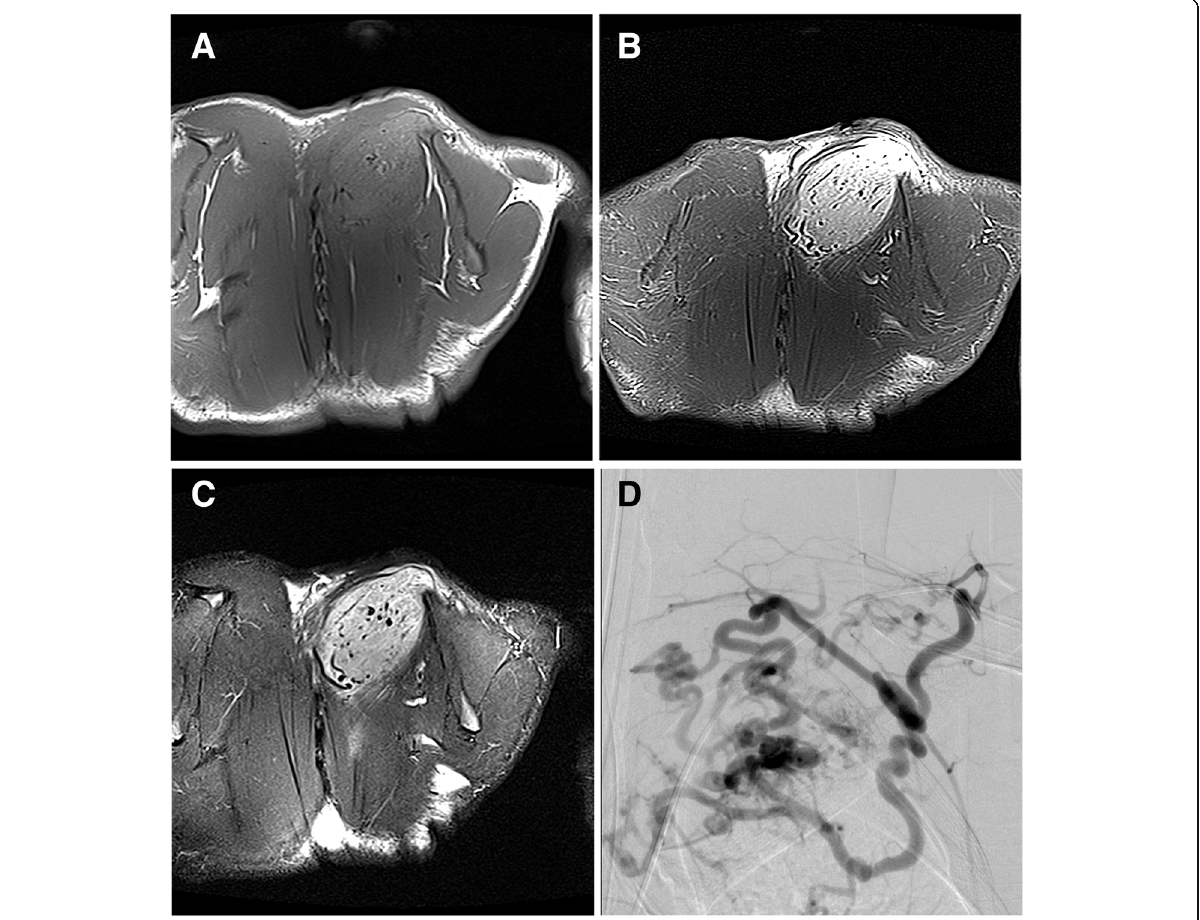
Fig. 1 a , b Pre- and post-contrast coronal T1-weighted images, respectively, demonstrate an avidly enhancing mass in the left upper back. c T2- weighted coronal image with fat saturation demonstrates large flow voids consistent with abnormal arterial supply. d Frontal digital subtraction angiography demonstrates enlarged, abnormal feeding vessels arising from a branch of the subclavian